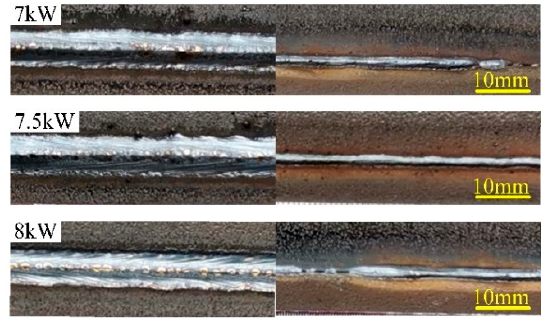
Figure 5. The shape of weld seam with different laser powers.